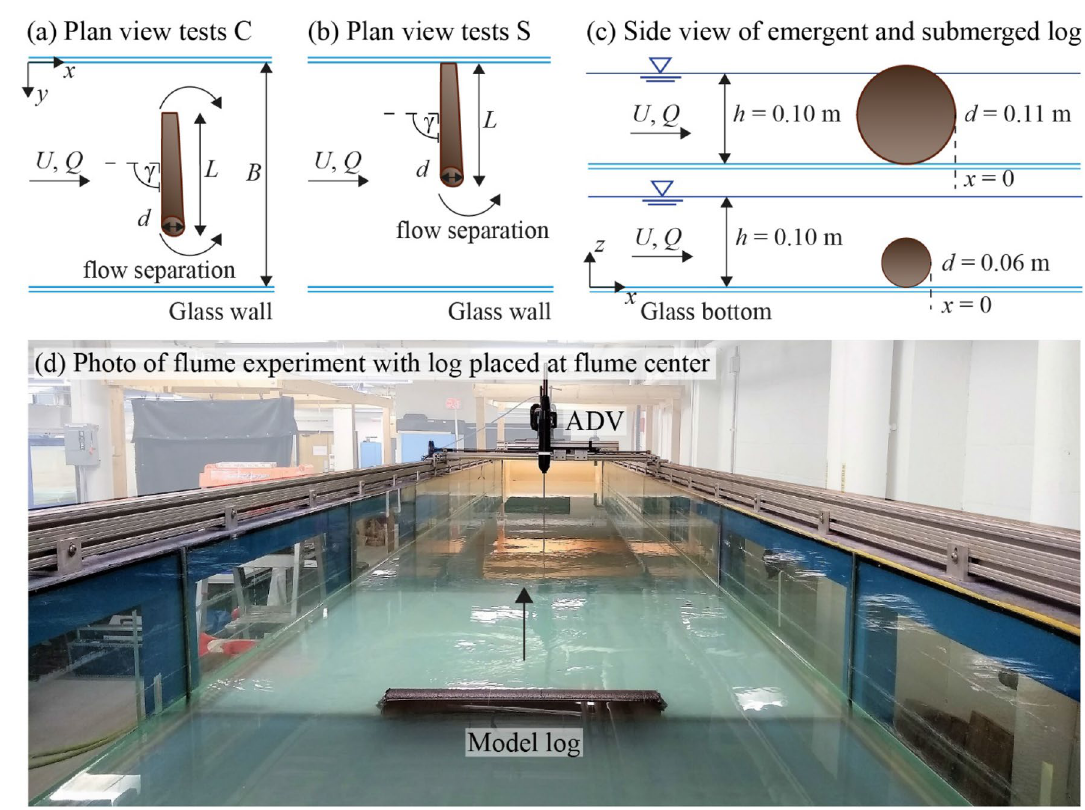
Figure 2. ( a ) Plan view of test setup with log positioned at channel center, denoted by “C” and ( b ) side, denoted by “S”, with U = cross-sectional averaged flow velocity, Q = discharge, d = log diameter, L = log length, γ = log orientation angle, B = channel width, and h = flow depth; ( c ) side view of emergent and submerged log; ( d ) photo of flume experiment looking downstream. Note that x = 0 was defined at the downstream trailing edge of the